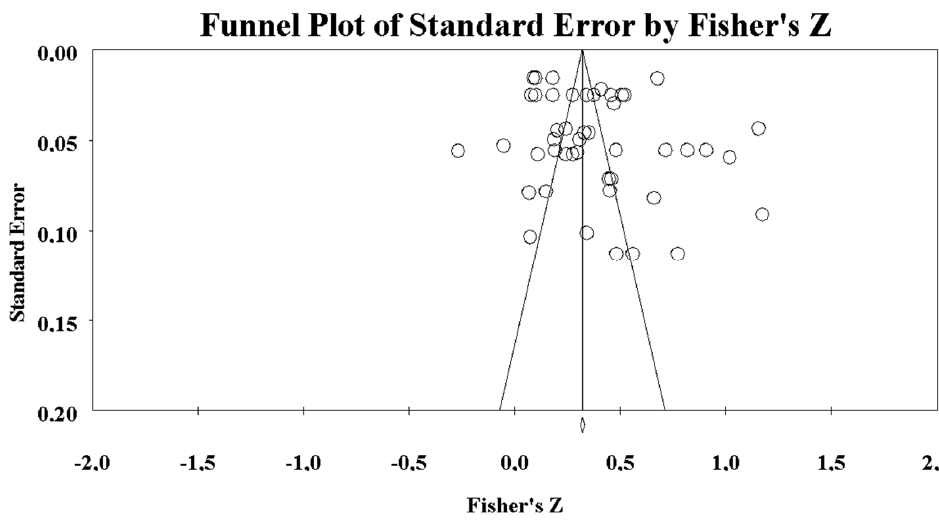
Figure 3. Funnel plot and standard